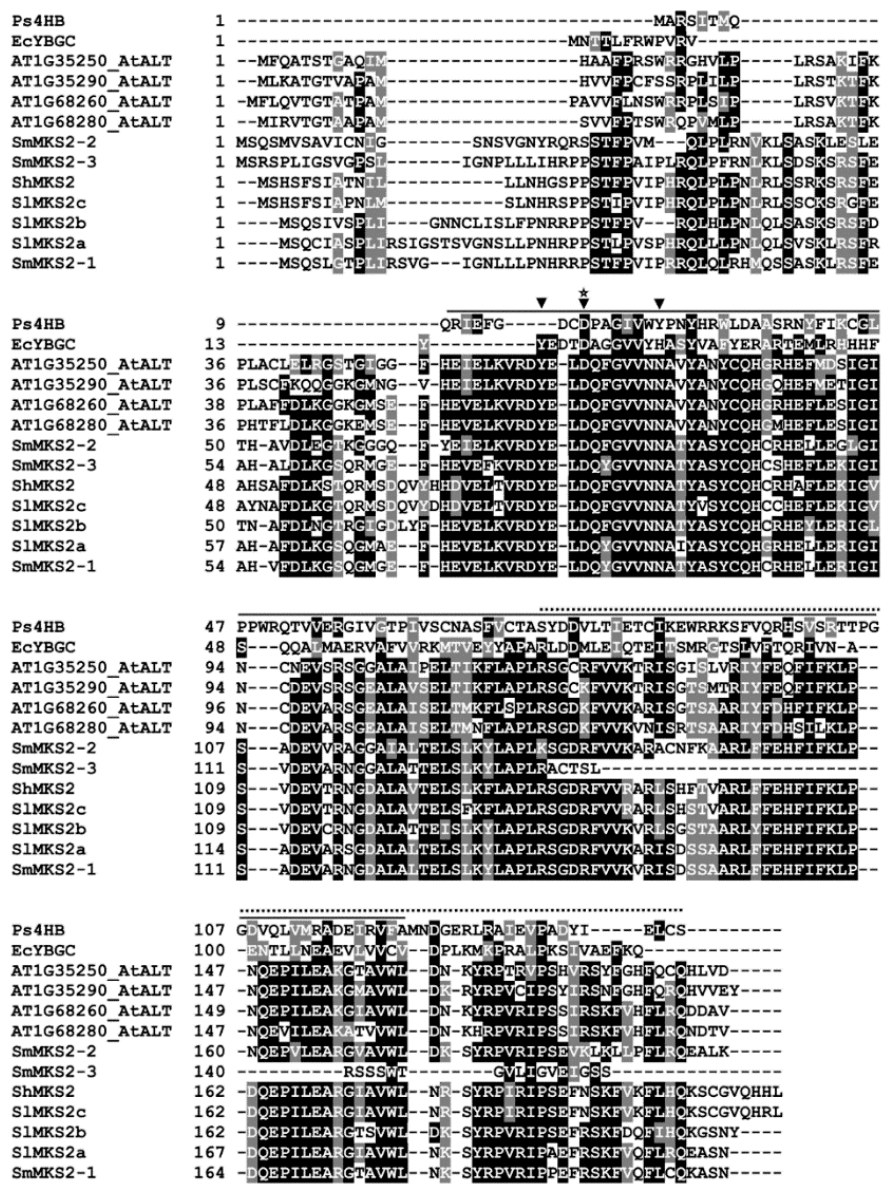
Figure 1. Amino acid sequence alignment of SmMKS2 with functionally characterized methylketone synthase 2 / acyl-lipid thioesterases (MKS2 / ALTs). The deduced amino acid sequences of SmMKS2-1 , SmMKS2-2 , and SmMKS2-3 are compared to previously reported At1g68260 (AEE34774.1), At1g68280 (AEE34776.2), At1g35290 (AEE31776.1), and At1g35250 (AEE31773.1) from A. thaliana , ShMKS2 (ADK38536.1) from the wild tomato Solanum habrochaites , SlMKS2a (ADK38541.1), SlMKS2b (ADK38542.1) and SlMKS2c (ADK38543.1) from the cultivated tomato Solanum lycopersicum , Ps4HB (EF569604) from Pseudomona , and EcYbgC from Escherichia coli. Identical residues are highlighted in black and similar residues are highlighted in grey. The arrowheads indicate positions of catalytic residues defined in members of the thioesterase family 9, including the structurally resolved EcYbgC from E. coli . The conserved Asp residue required for thioester bond cleavage is marked with star. Black horizontal line indicates the conserved Hotdog fold region present in MKS2 / ALTs, and the dashed horizontal line indicates C-terminal residues lost in SmMKS2-3 and replaced by new amino acids encoded by 47 intronic nucleotides plus the first nucleotide of exon